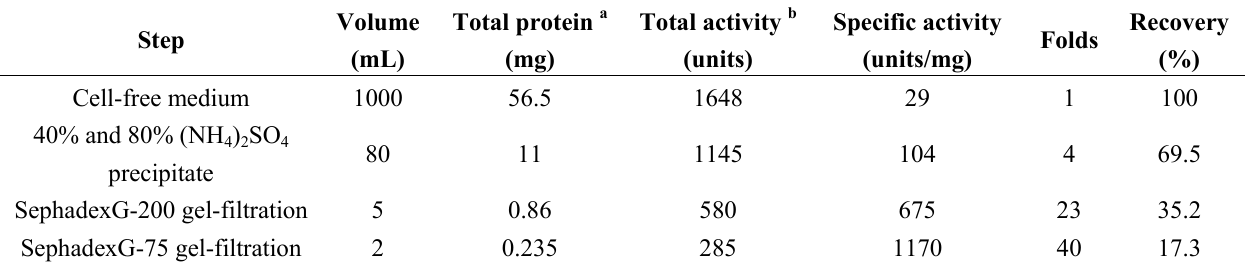
Table 1. Purification of the κ-carrageenase from Cellulophaga lytica strain